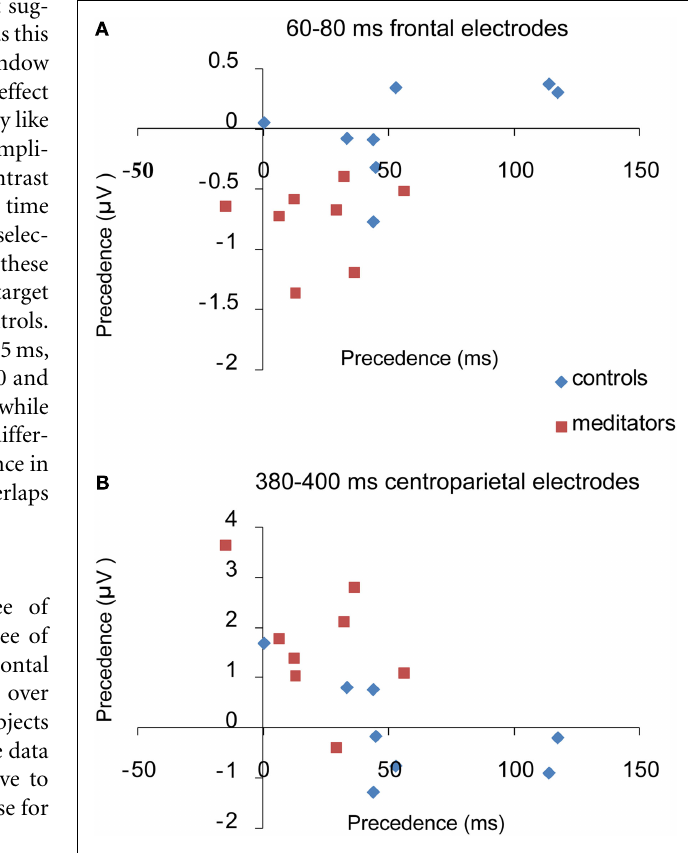
FIGURE 8 | Brain behavior correlations. This figure shows the pearson correlation between the amount of precedence in the average RT and the amount of precedence in ERP amplitude, per subject. Precedence is measured by the reaction time or amplitude for local targets minus the reaction time or amplitude for global targets. (A) Shows a significant negative correlation between precedence in the ERP and precedence in RT between 60 and 85ms. (B) Shows a significant negative correlation between 380 and 400ms. As precedence in the reaction time decreases, precedence in the amplitude of the ERP